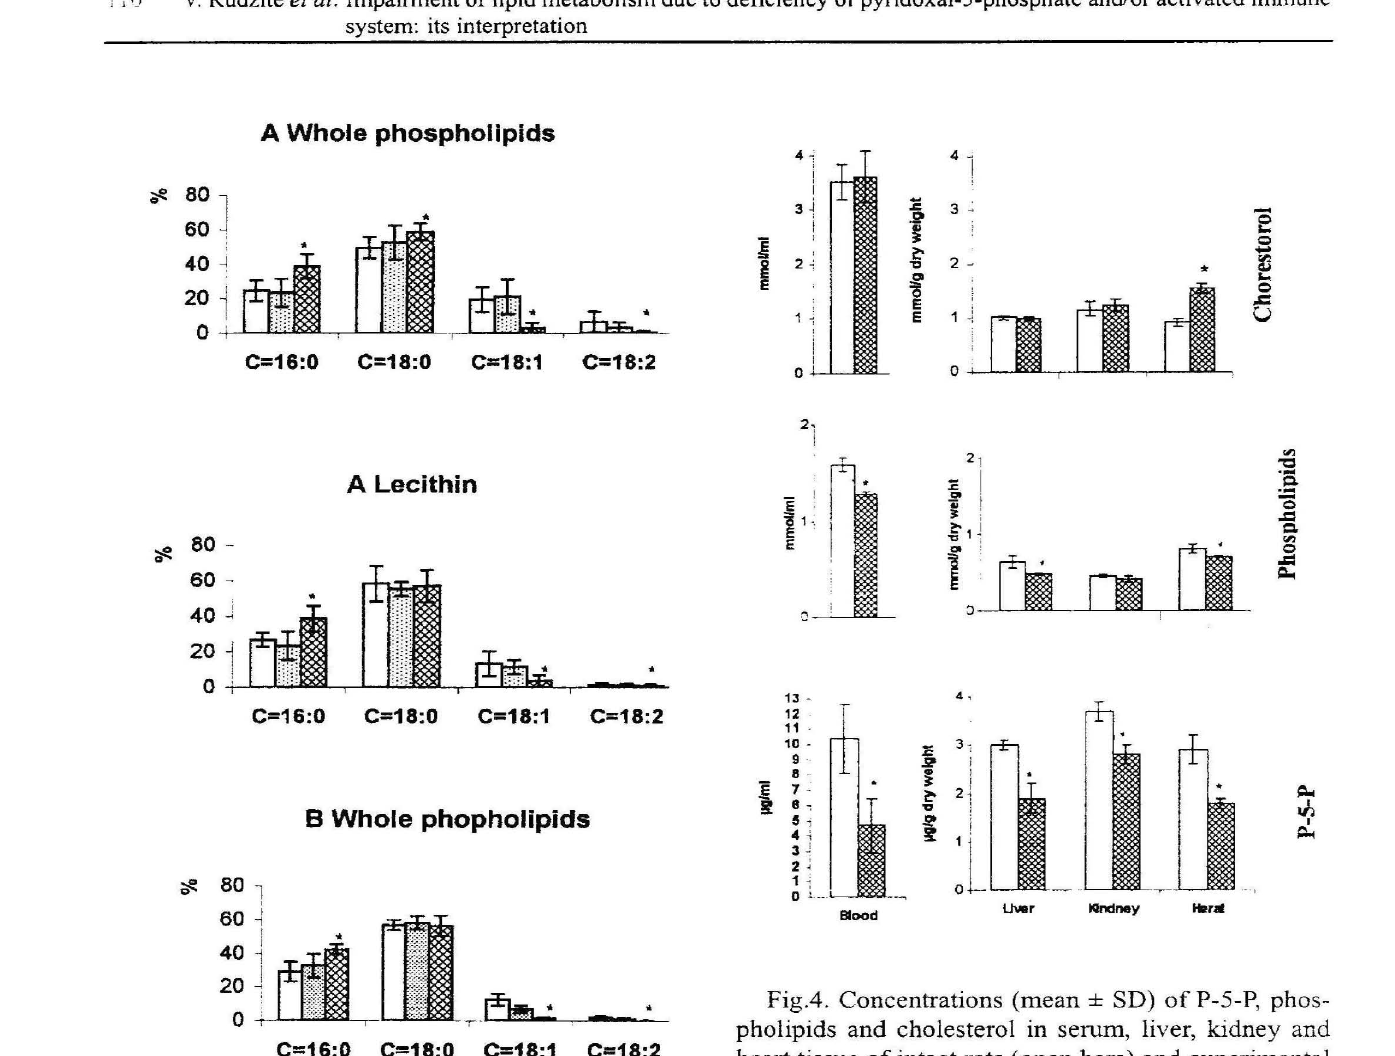
FigA. Concentrations (mean ± SD) of P-5-P, phos pholipids and cholesterol in serum, liver, kidney and heart tissue of intact rats (open bars) and experimental rats that 2 months peroral received 20 mg isoniazidlkg wet weight daily (hatched bars); the difference is sta tistically significant (P <